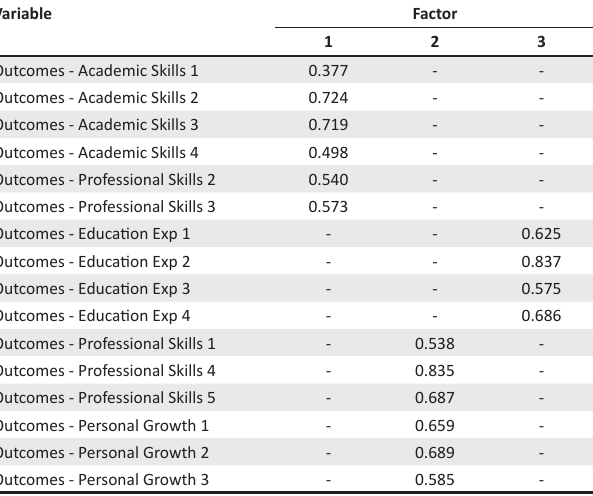
TABLE 3: Factor matrix for graduate